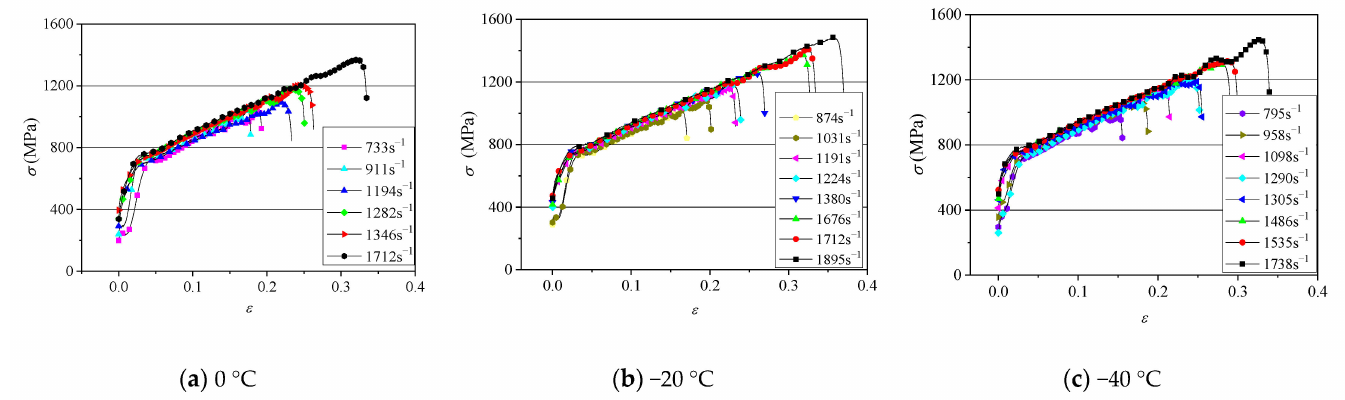
Figure 12. Stress–strain curves of EH36 at high strain rate from − 40 ◦ C to 0 ◦